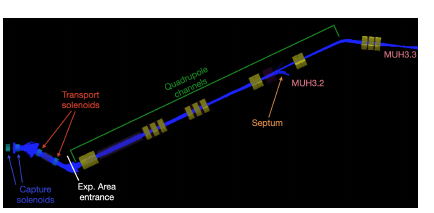
Figure 9. MUH2 beamline model in G4beamline [16] including the double Wien filter separation scheme and the graded-field capture solenoid. TgH is positioned at the in- tersection of the axes on the right. The muon beam (green lines) is captured from the capture solenoid and transported to the entrance of the experimental area located on the downstream side of the last transport solenoid on the left.